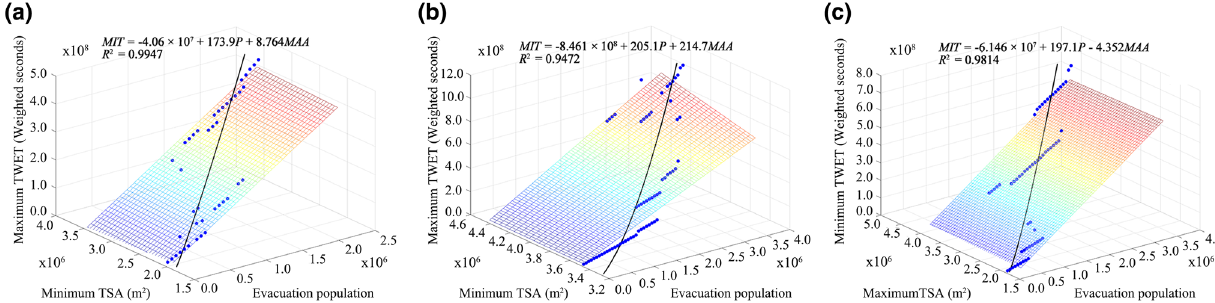
Fig. 10 Fitting surfaces of minimum total weighted evacuation time (MIT), maximum total shelter area (MAA), and evacuation population. a – c Location 1, Location 2, and Location 3,